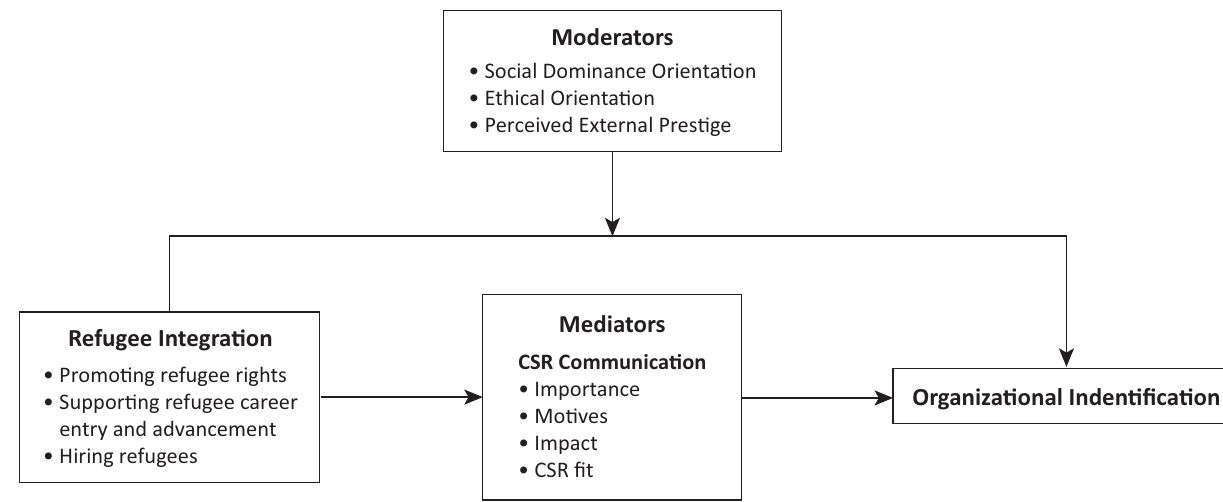
Figure 1. The mediating and moderating mechanisms of the relationship of refugee integration and organizational